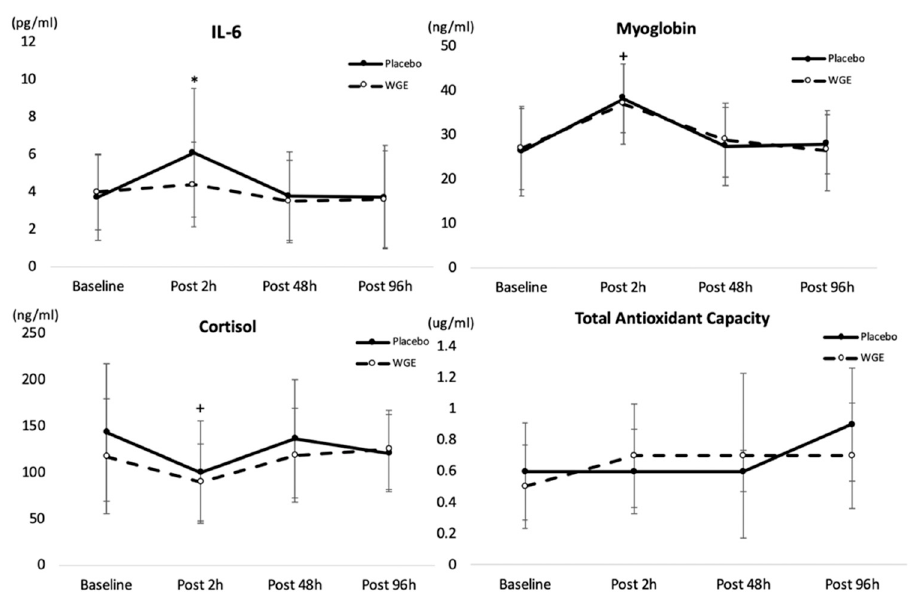
Figure 1. The results of blood markers of muscle damage.